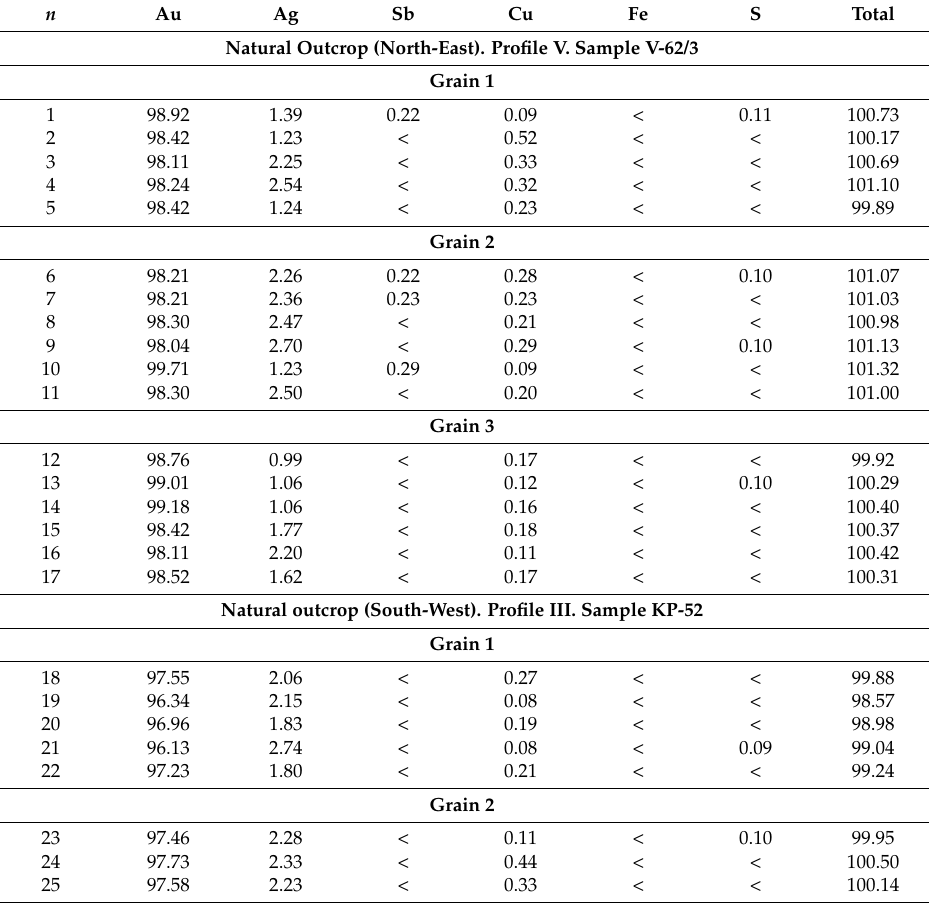
Table 5. Representative EPMA analyses of native gold from the Amurskie Daiki deposit (wt %).